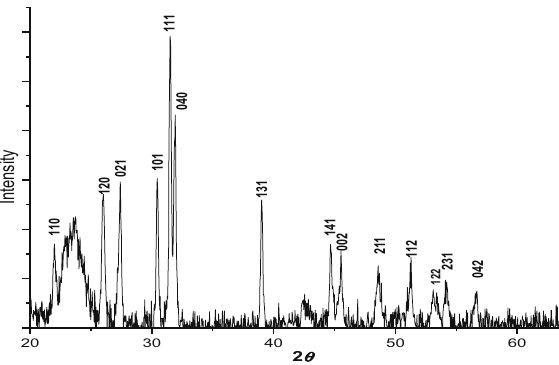
Figure 3: A representative X - ray di ff raction pattern of [( CH 3 ) 2 SnL 2 ] ( 1 ) residue showing a herzenbergite structure of SnS ( JCPDS no. 39 - 0354 ) .